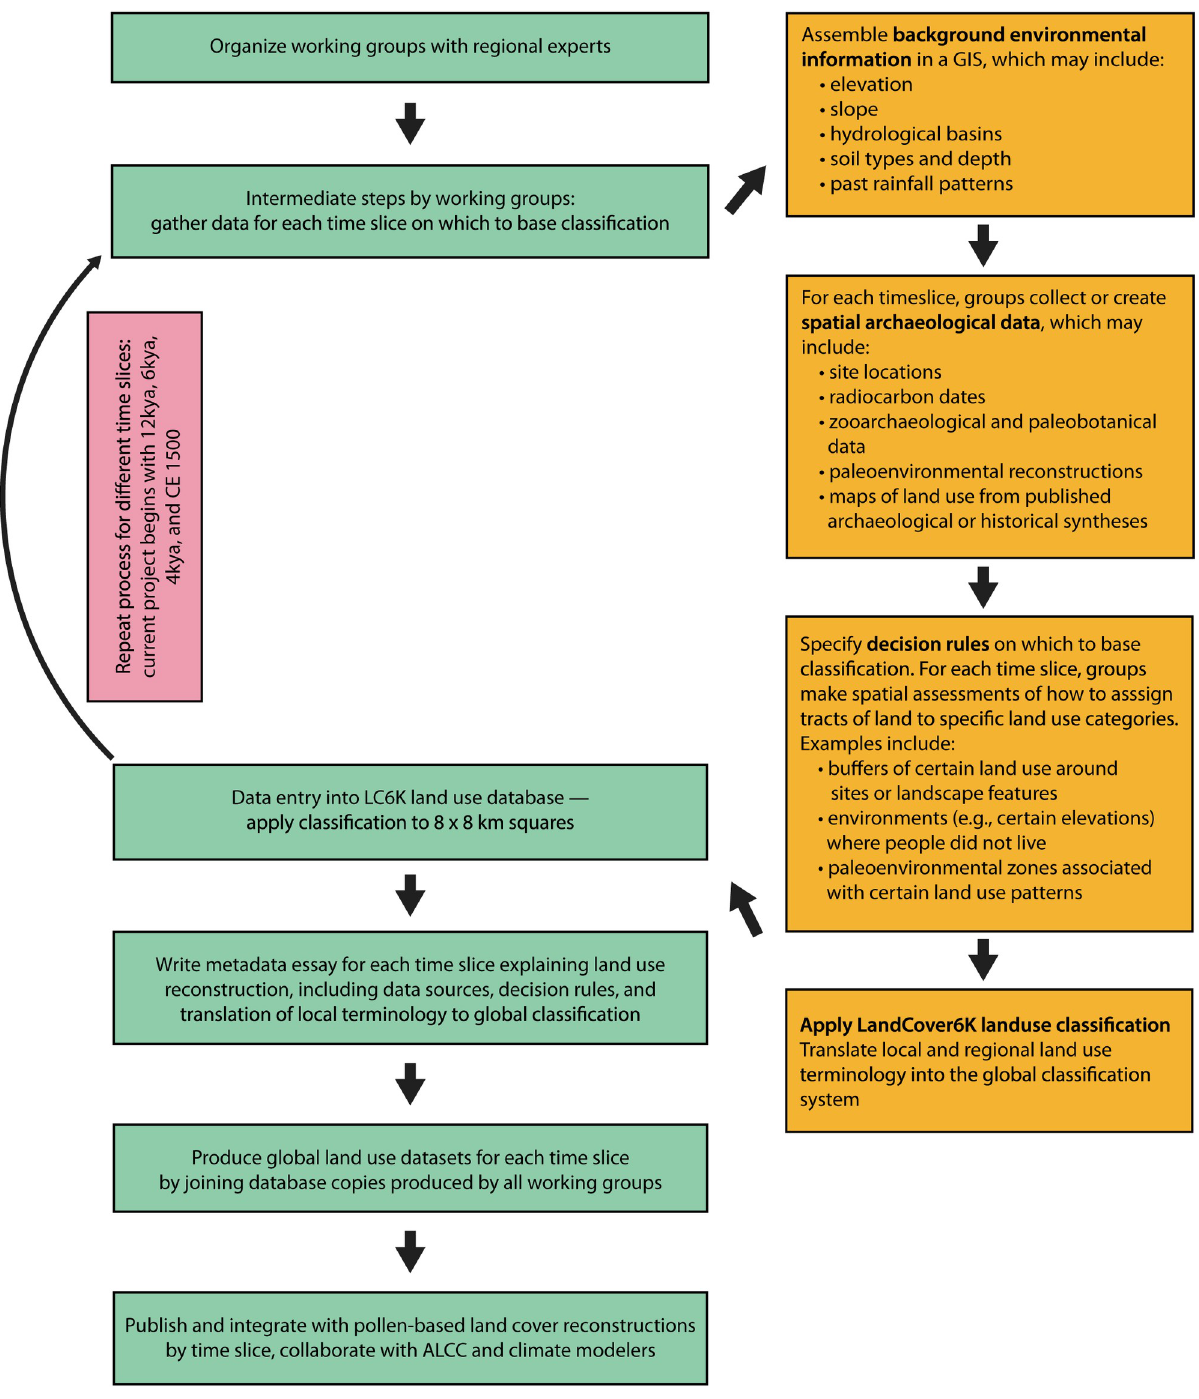
Fig 9. Land Use classification flowchart showing the generalized processes LandCover6k is using to translate regional archaeological data into a spatial format using the classification scheme and the accompanying geospatial database described in the paper.